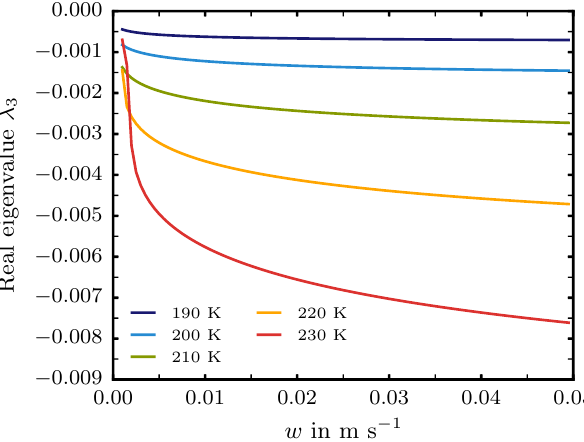
Figure 4. Real eigenvalue λ 3 of the Jacobian DF | x rium point x 0